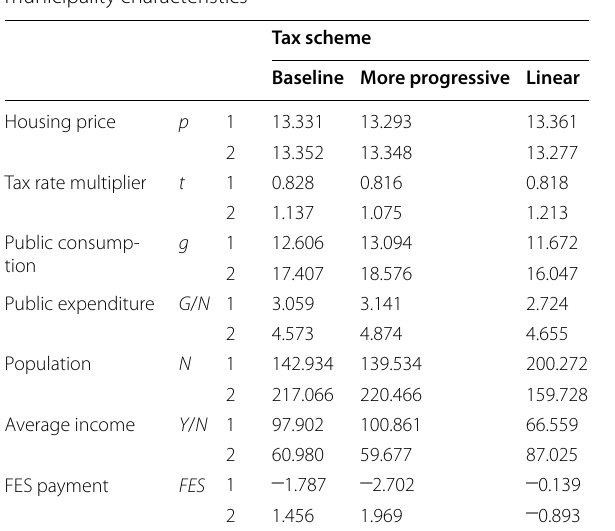
Table 6 Changing the progressive tax scheme: effect on municipality characteristics